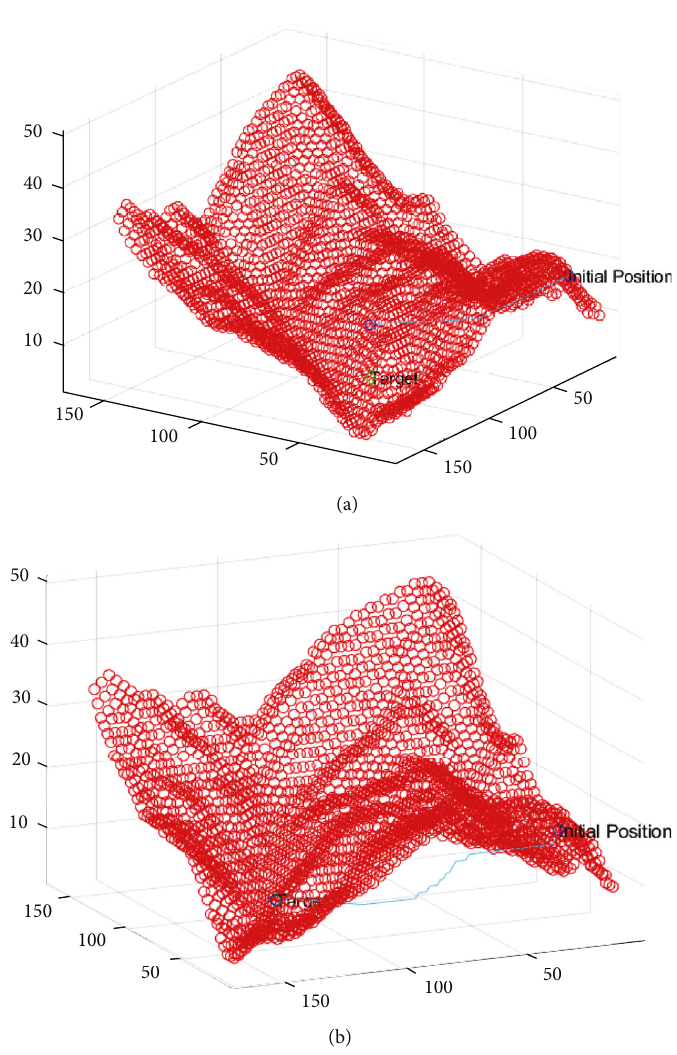
Figure 10: Path planning for simulating group 3 with the optimal A ∗ algorithm (a) and traditional A ∗ algorithm